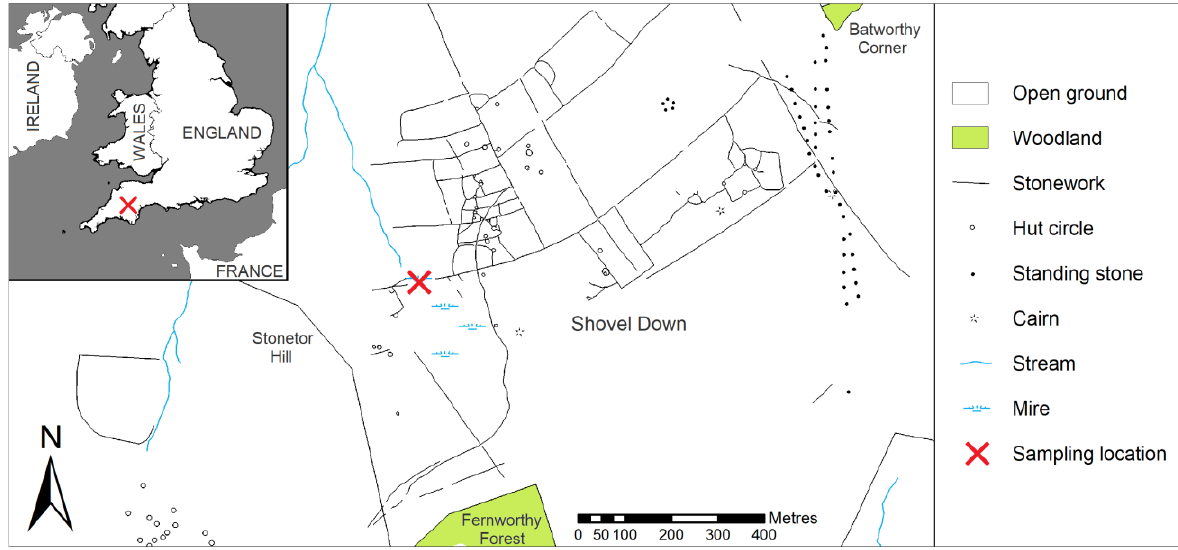
Figure 1. Location of the peat coring site in relation to exposed archaeology at Shovel Down, and (inset) location of the site in southwest England (red ‘X’). Ordnance Survey data © Crown copyright and database right